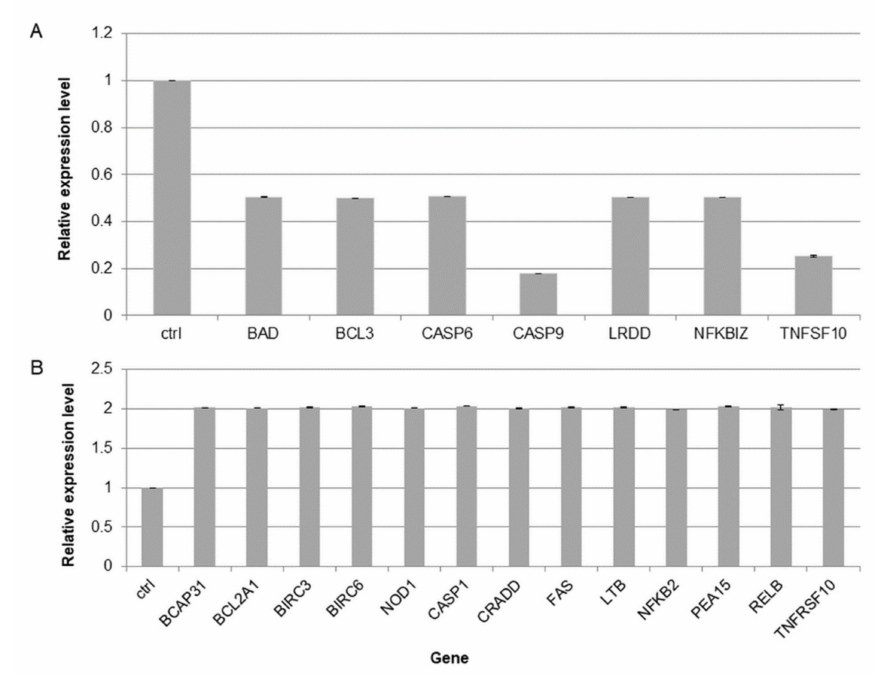
Figure 12. The expression levels of death-associated genes in SKOV-3 cells treated with K. daigre- montiana water extract at a concentration of 70 µ g/mL for 24 h. The expression levels of genes were normalized to the GAPDH endogenous control gene, and their levels are presented as average values ± SD obtained from two independently performed experiments. The results are shown as fold changes under ( A ) or over ( B ) the value of 1.0